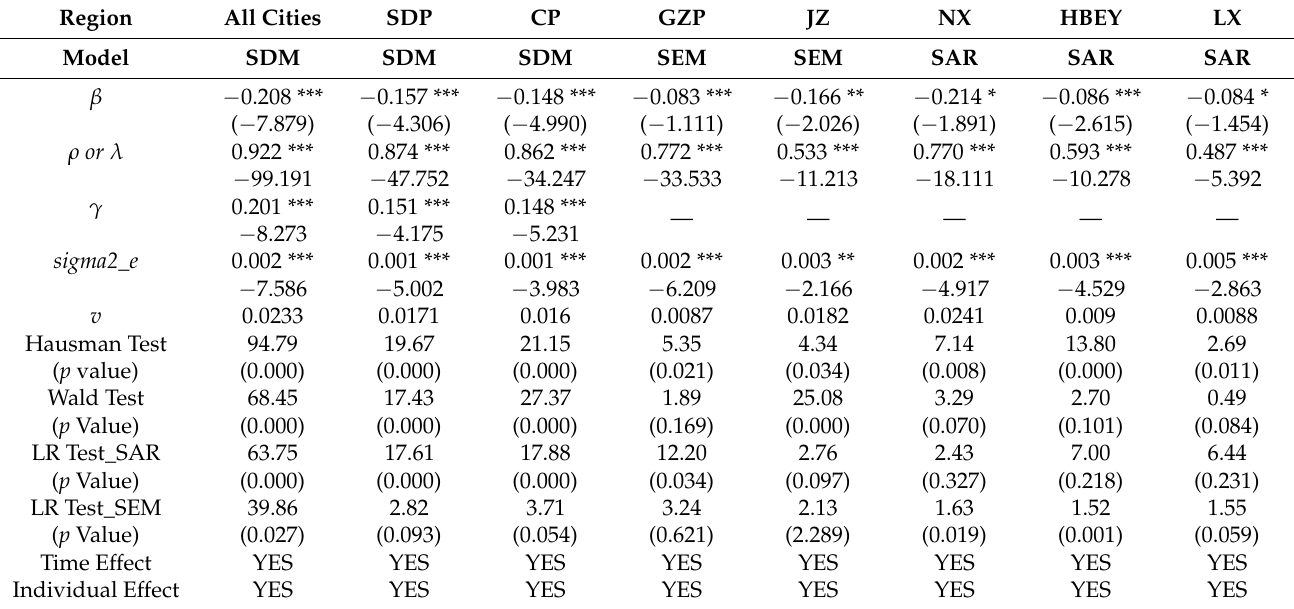
Table 4. Absolute β convergence characteristics of CEI for urban agglomerations in the